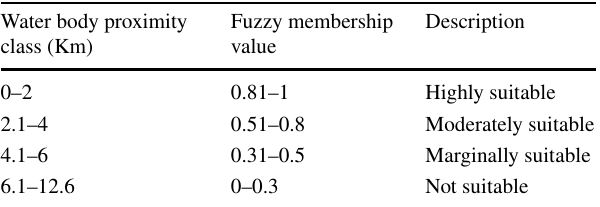
Fig. 11 Fuzzy membership values for a soil depth, b water body proximity Table 7 Criteria for classification of distance to rivers in the study area